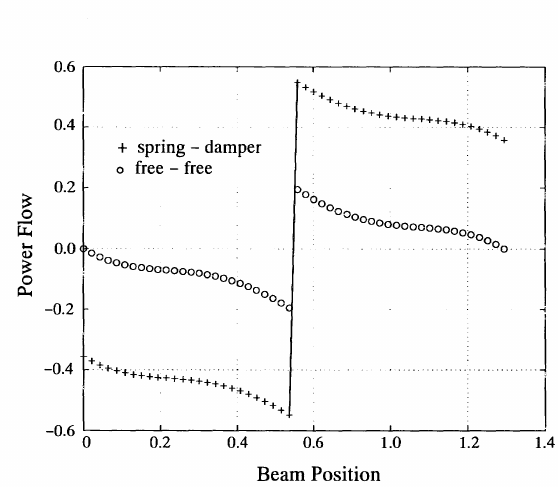
FIGURE 4 Effects of boundary conditions on power